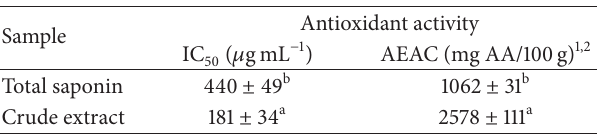
Figure 2: Ferrous ion chelating activity of total saponin and crude extracts of C. borivilianum . Data are expressed as means ± SD ( 𝑛 = 3 ). Table 1: Free radical scavenging activity of crude and total saponin extract from mother plant tubers of C. borivilianum